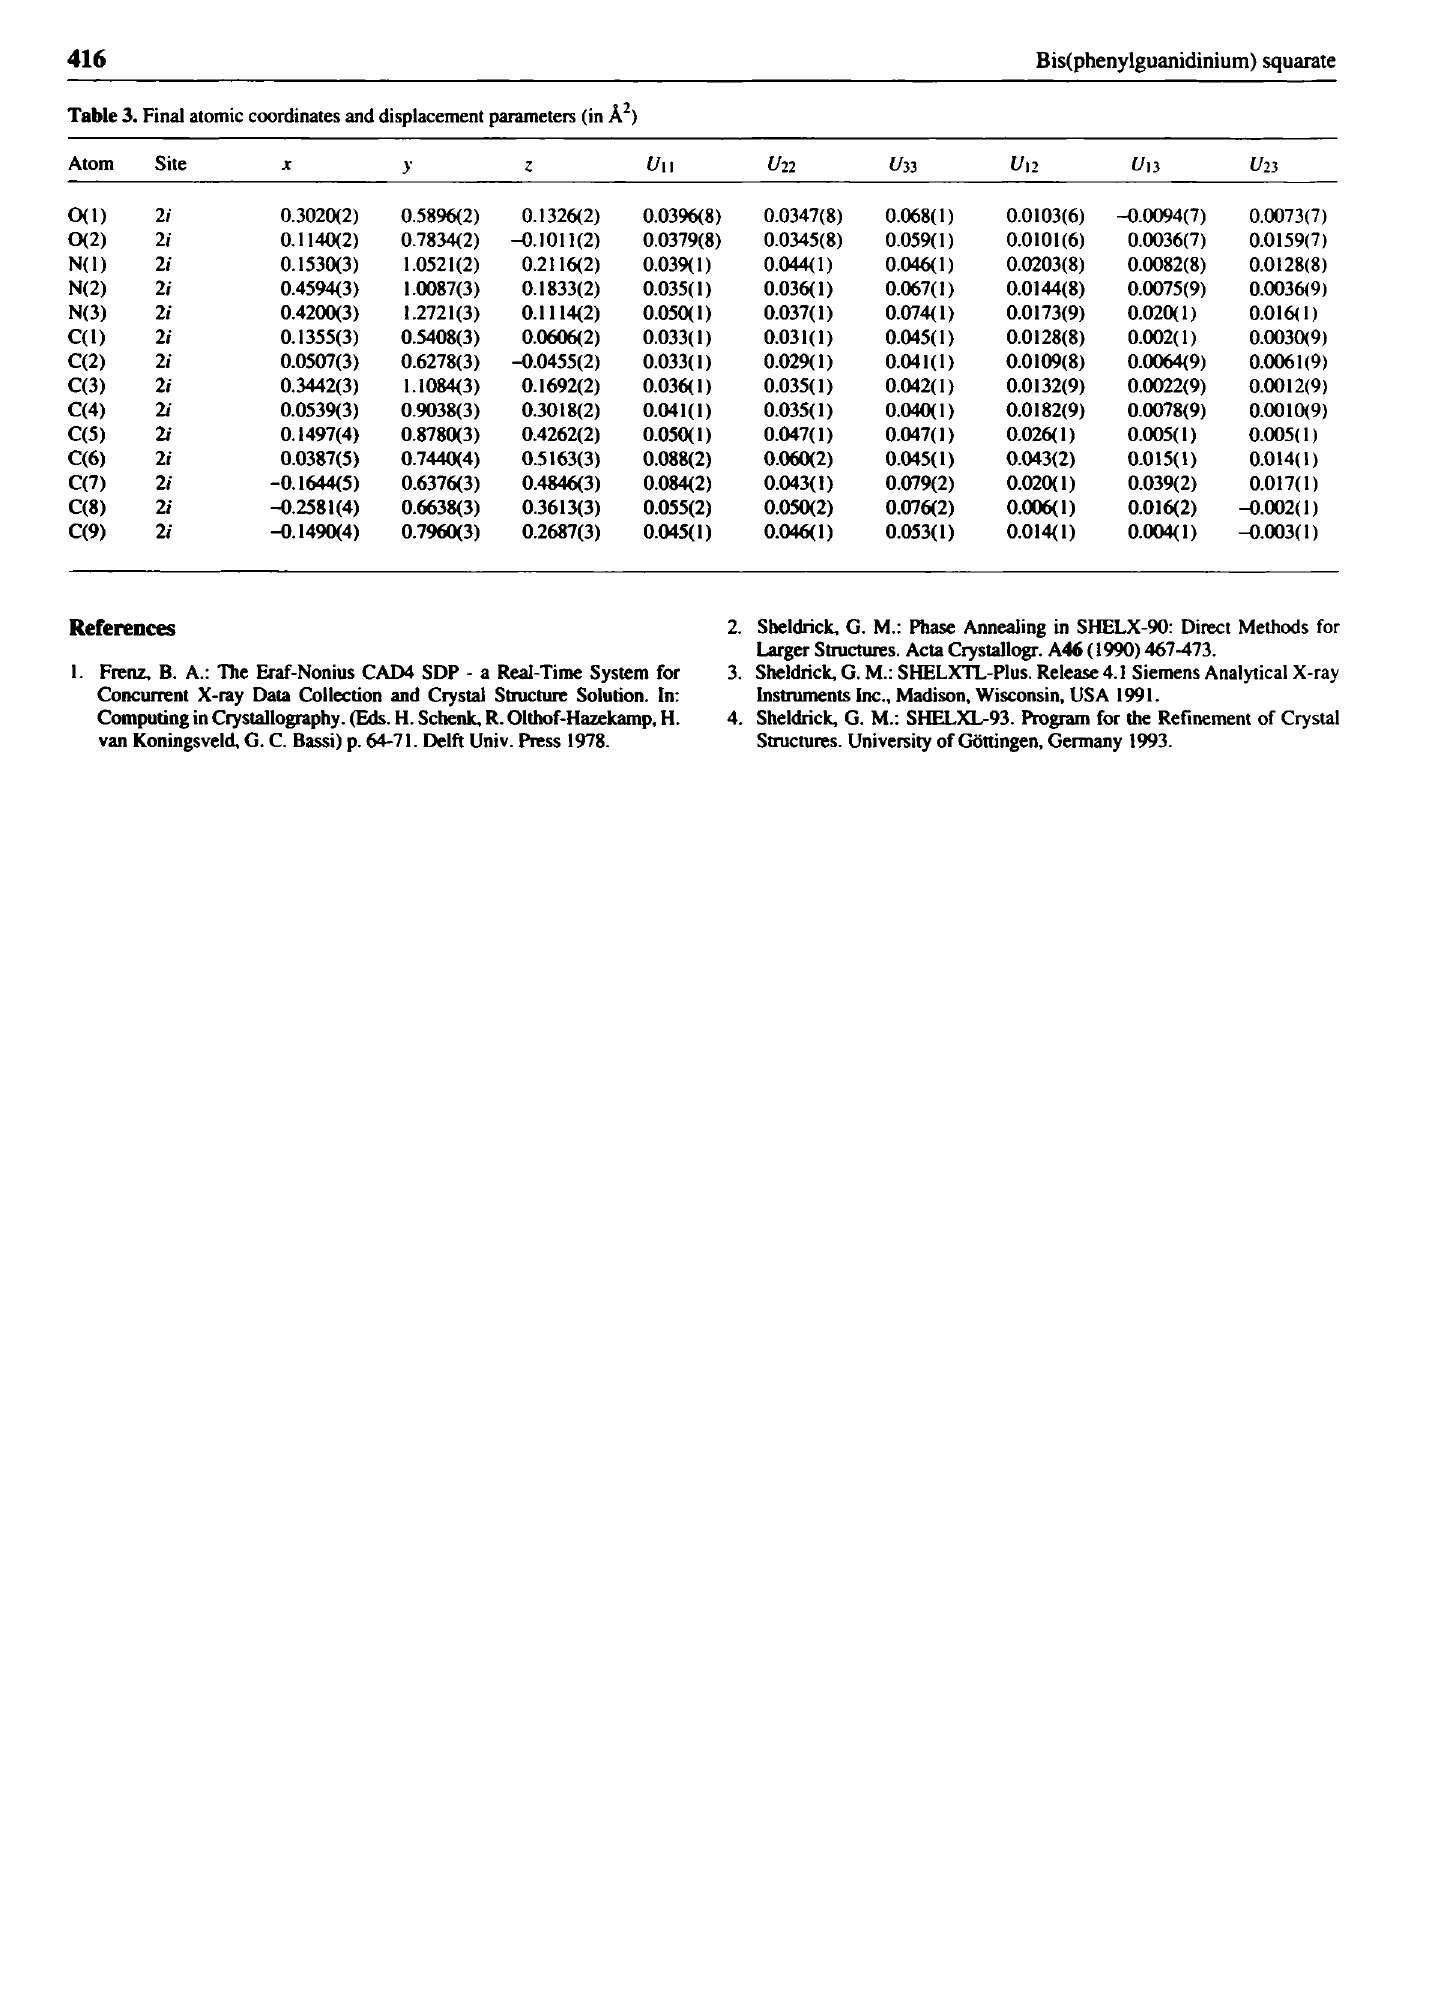
Table 3. Final atomic coordinates and displacement parameters (in Â 2